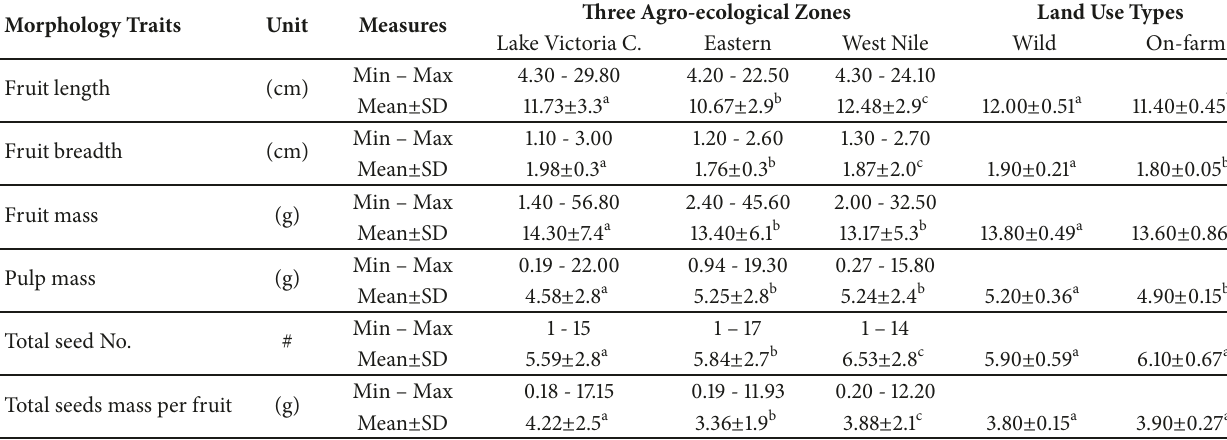
Table 2: T. indica fruits and seeds morphological/quantitative traits.